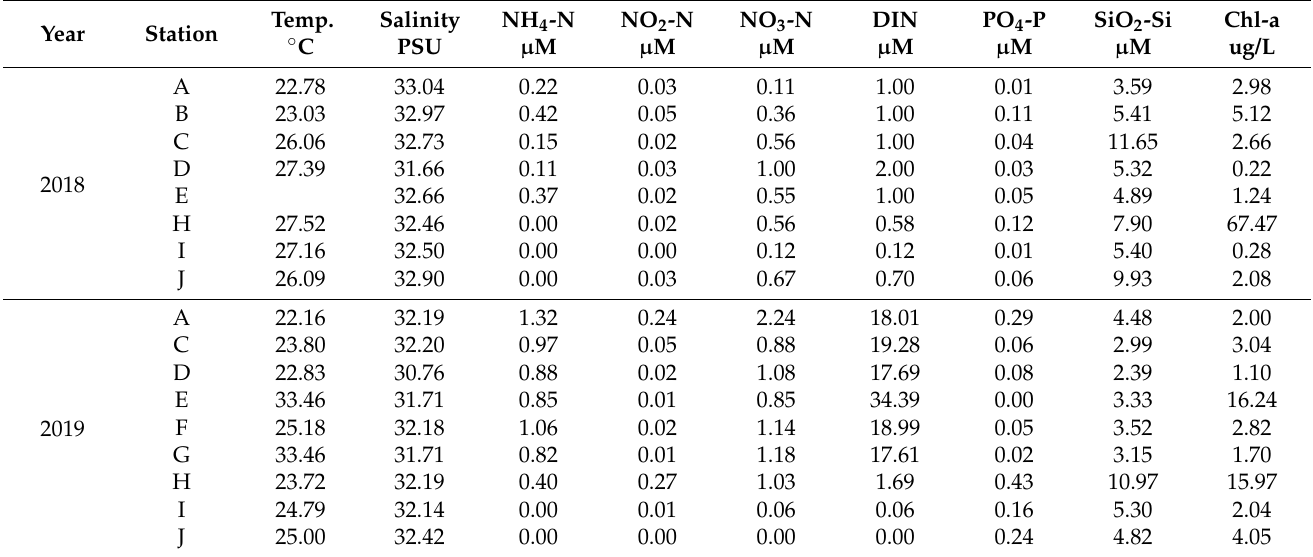
Table 2. Environmental parameters during C. polykrikoides nlooms in Korean coastal